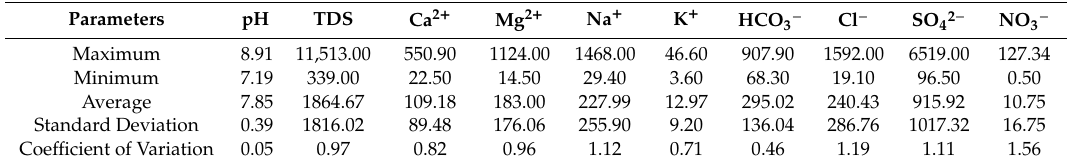
Table 3. Statistical summary of the hydrochemistry of groundwater samples collected from the Jinta Basin,